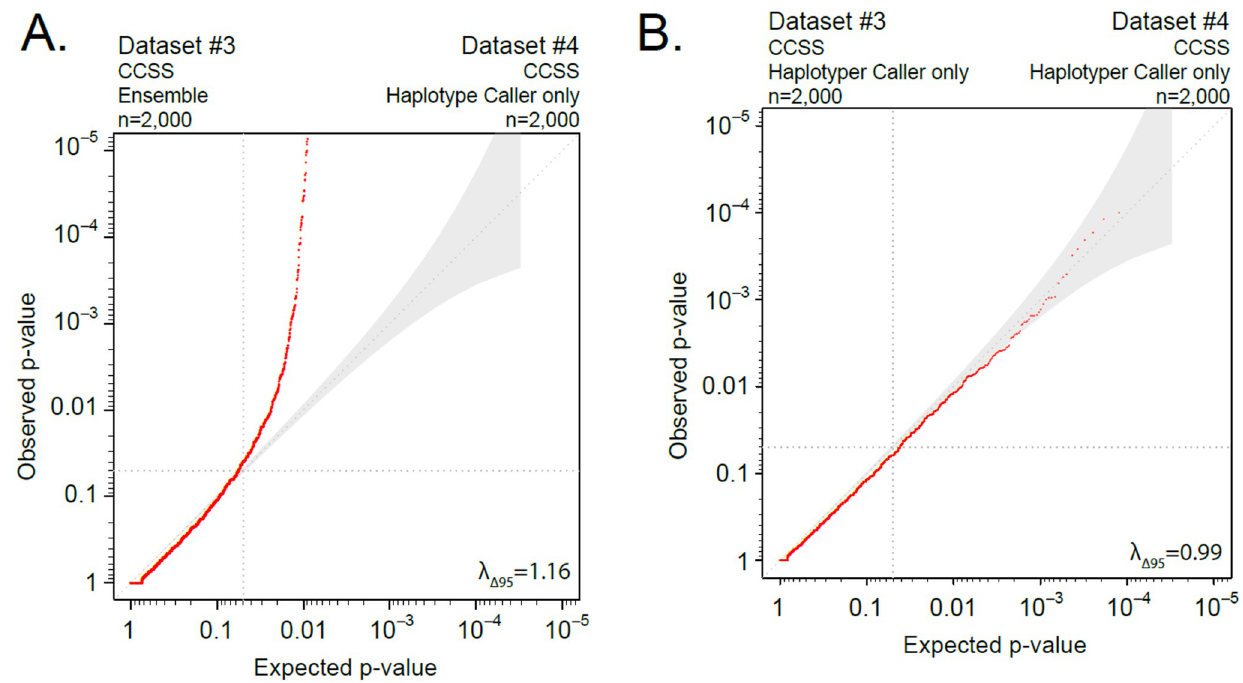
Fig 4. Use of different (A) and same (B) variant-calling pipelines. Quantile-quantile plot of distribution of p-values from synonymous variants in sub- sampled CCSS data (n = 4000) randomly divided (n = 2000 each) and called with (A) different callers (Ensemble vs. HaplotypeCaller) or (B) same caller (HaplotypeCaller) and post-variant filtering. In panel A, we observed inflated p-values deviating from the 95% confidence interval (shading), while in panel B, we observed no deviation from the 95% confidence interval (shading), consistent with minimal or no inflation of p-values.